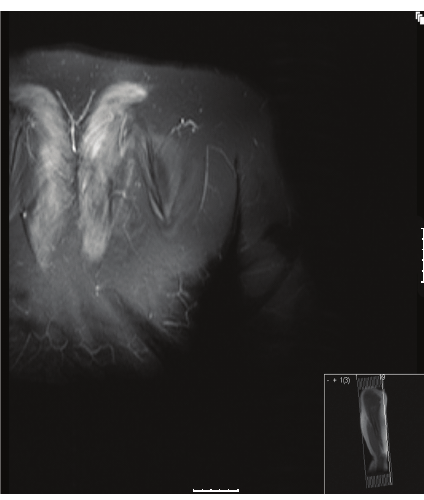
Figure 3: Bilateral increased intensity of the trapezius in the STIR sequence (MRI sagittal section in smaller